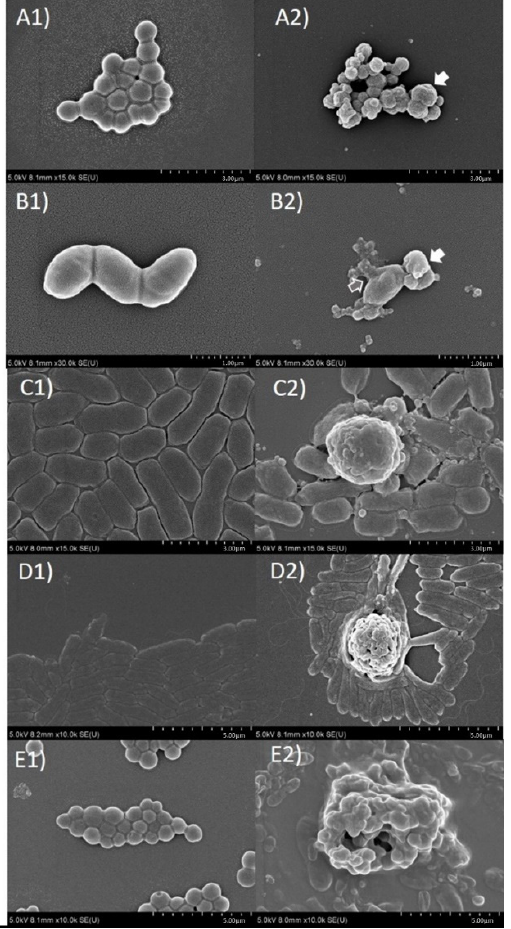
Figure 3. Scanning electron microscopic micrograph (SEM) of clinically isolated bacteria after treatment with young fruit extract of O. indicum (OIFY) at the concentration of 5 mg/mL; ( A1 ) = Staphylococcus intermedius without OIYF treatment, ( A2 ) = Staphylococcus intermedius with OIFY treatment; ( B1 ) = Streptococcus suis without OIYF treatment, ( B2 ) = Streptococcus suis with OIYF treatment, ( C1 ) = β -hemolytic Escherichia coli without OIYF treatment, ( C2 ) = β -hemolytic Escherichia coli with OIYF treatment, ( D1 ) = Pseudomonas aeruginosa without OIYF treatment, ( D2 ) = Pseudomonas aeruginosa with OIYF treatment, ( E1 ) = Staphylococcus aureus without OIYF treatment, ( E2 ) = Staphylococcus aureus with OIYF treatment. ( A2 , B2 ) White arrows = cell fusion, ( B2 ) Grey arrow = cellular content leakage.